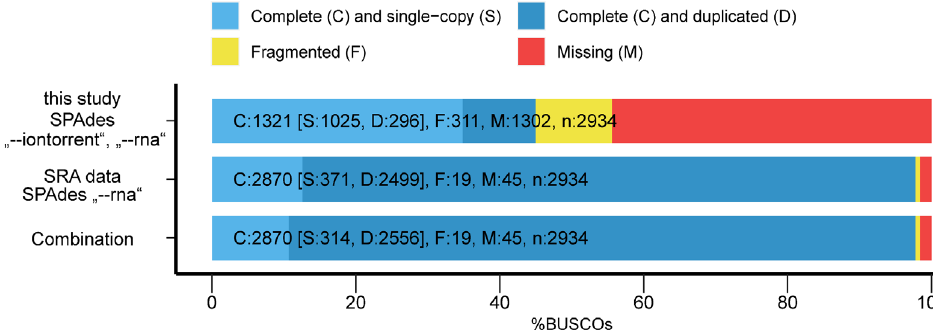
Figure 1. BUSCO assessment results for the de novo transcriptomes.